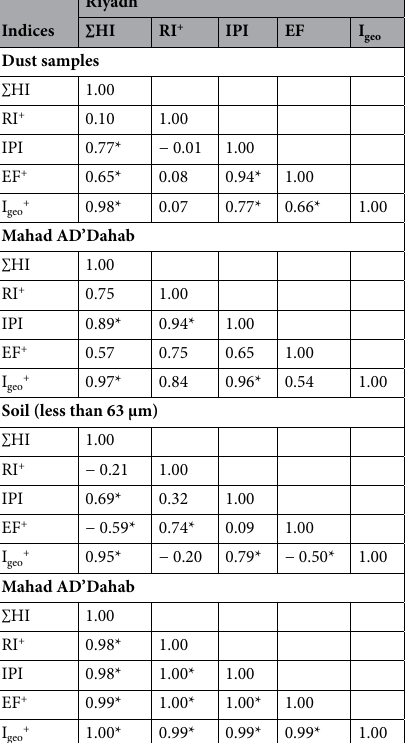
Table 8. Relationship between the characteristics of dust, soil pollution and the human health risks.